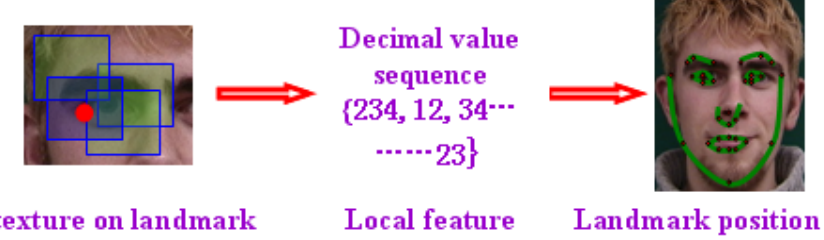
Figure 10. The landmark position update based on local feature regression.